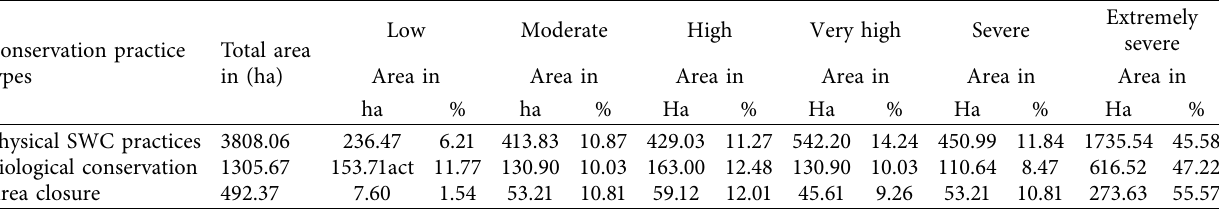
Figure 9: Map of existing soil and water conservation measures (Authors’ own map from field-collected data). Table 6: Area and percentage of existing conservation practices implemented at each soil erosion class (prepared from field data by the